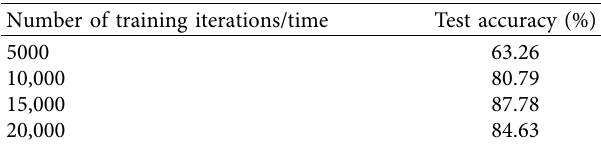
Table 1: The influence of the number of training iterations on the test accuracy.